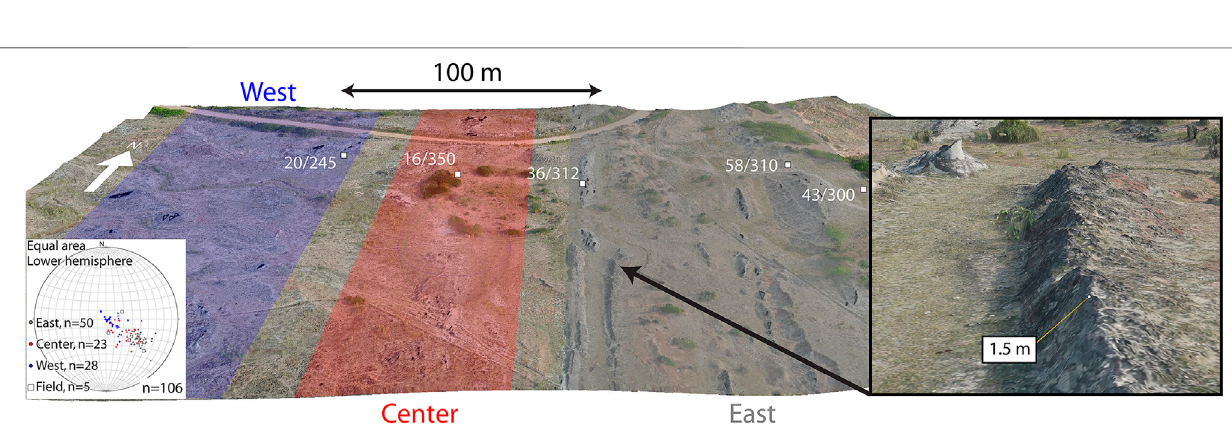
Frontiers in Earth Science |